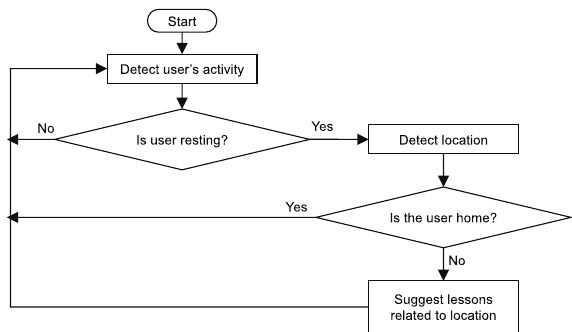
Figure 1. Workflow of